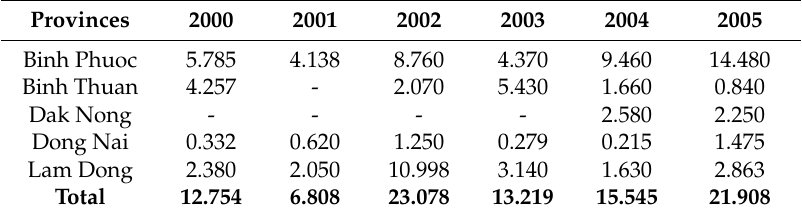
Table 7. Area of burned and destroyed forest from 2000 to 2005 [28] (units: km 2 ).